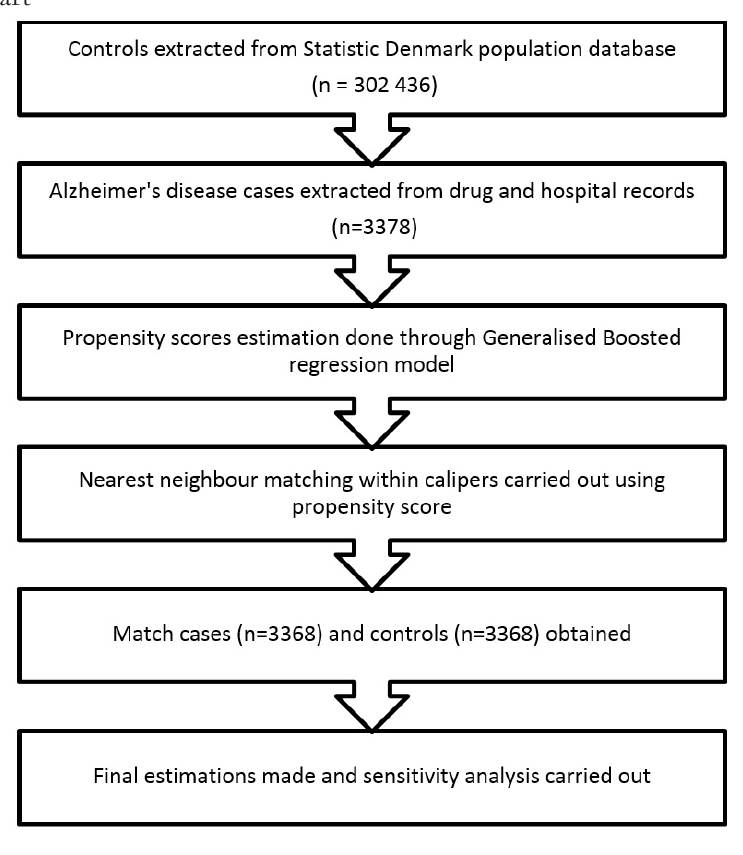
Table 1. Study Flowchart